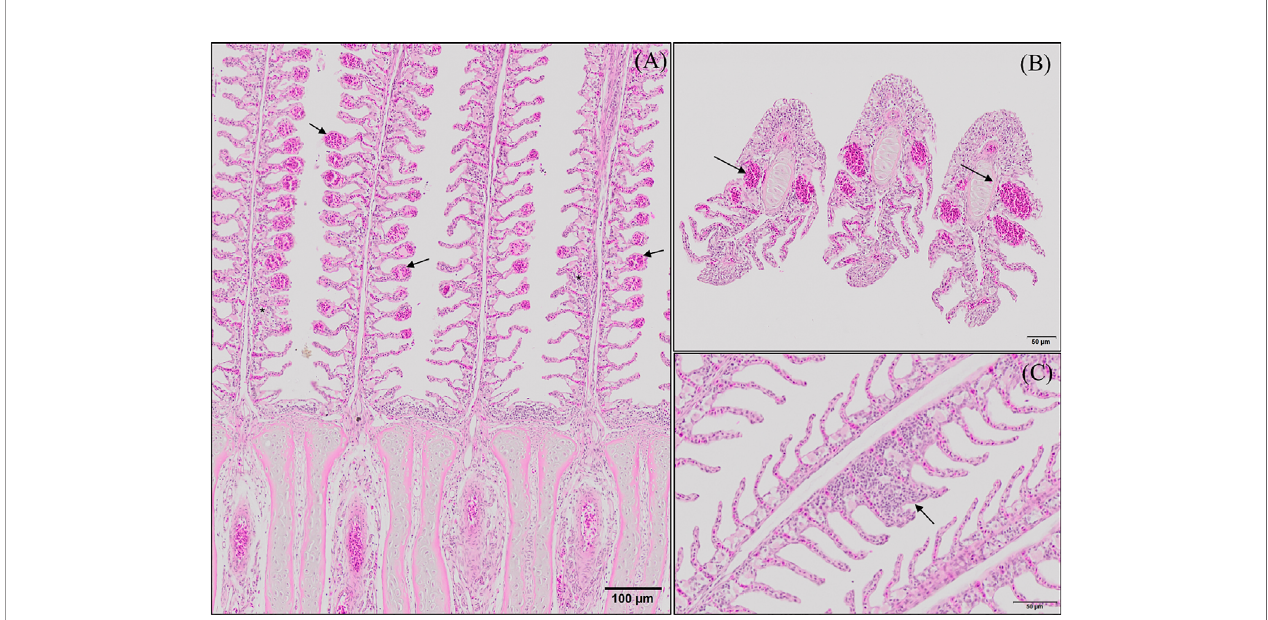
FIGURE 3 | Representative micrographs of the main morphological alterations found at the end of the experimental period on European sea bass ( Dicentrarchus labrax ) gills. (A, B) Longitudinal and transversal sections of the primary lamellae where severe telangiectasis and/or lamellar thrombosis are indicated with arrows (Hematoxilin – Eosin; Bar = 100 & 50 μm). Focal lamellar fusion is indicated with symbols (*). (C) Detail of primary lamella focal lamellar fusion. Observe the fi lling of interlamellar space with proliferating pavement cells. (Hematoxilin – Eosin; Bar = 50 μm). Fish fed PHYTO diet presented reduced incidence (p <0.05) of lamellar fusion compared to fi sh fed the rest of the dietary treatments.